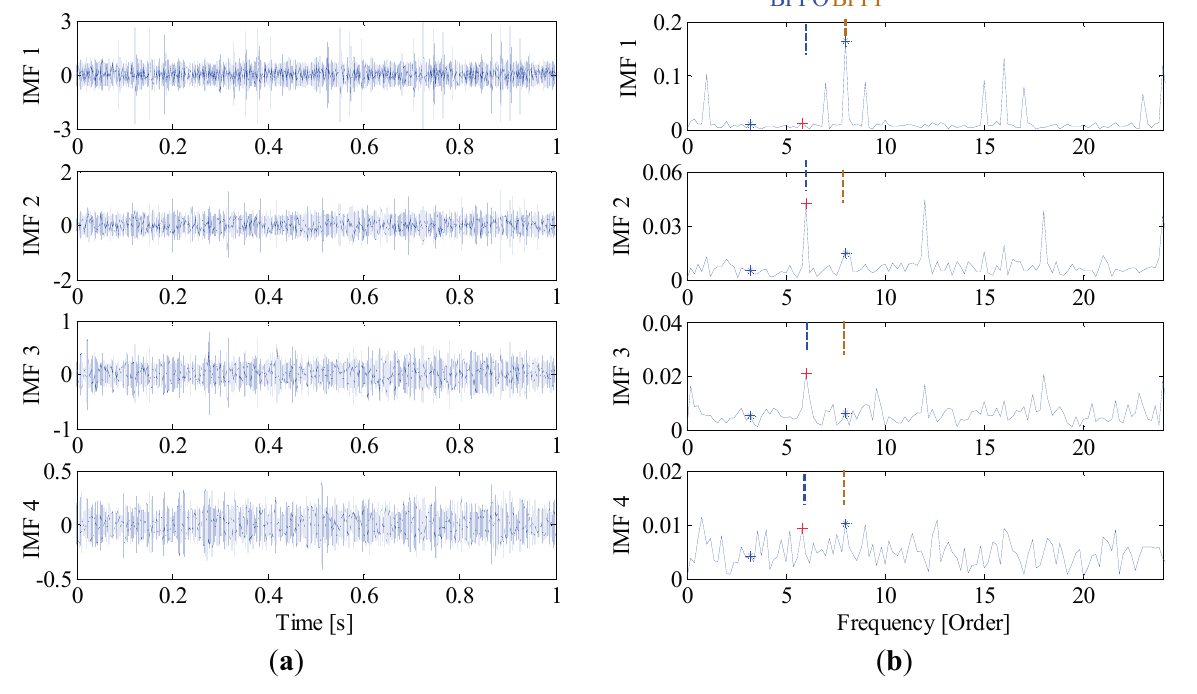
Figure 14. ( a ) Waveforms and ( b ) envelope order spectrums of the first 4 IMF